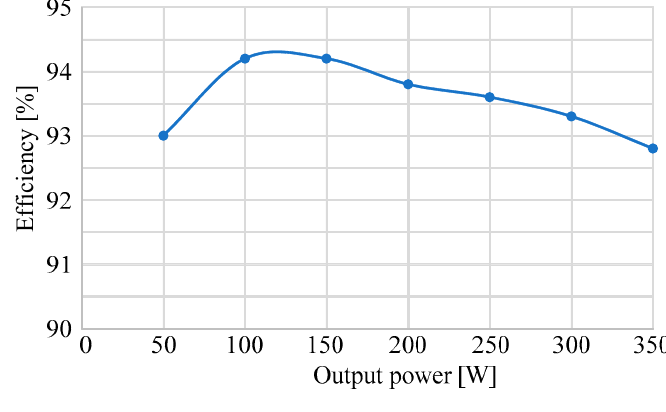
Figure 8. Switching waveforms.